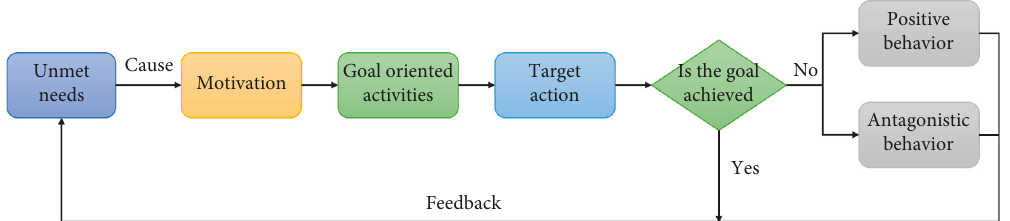
Figure 2: The schematic diagram of behavioral science